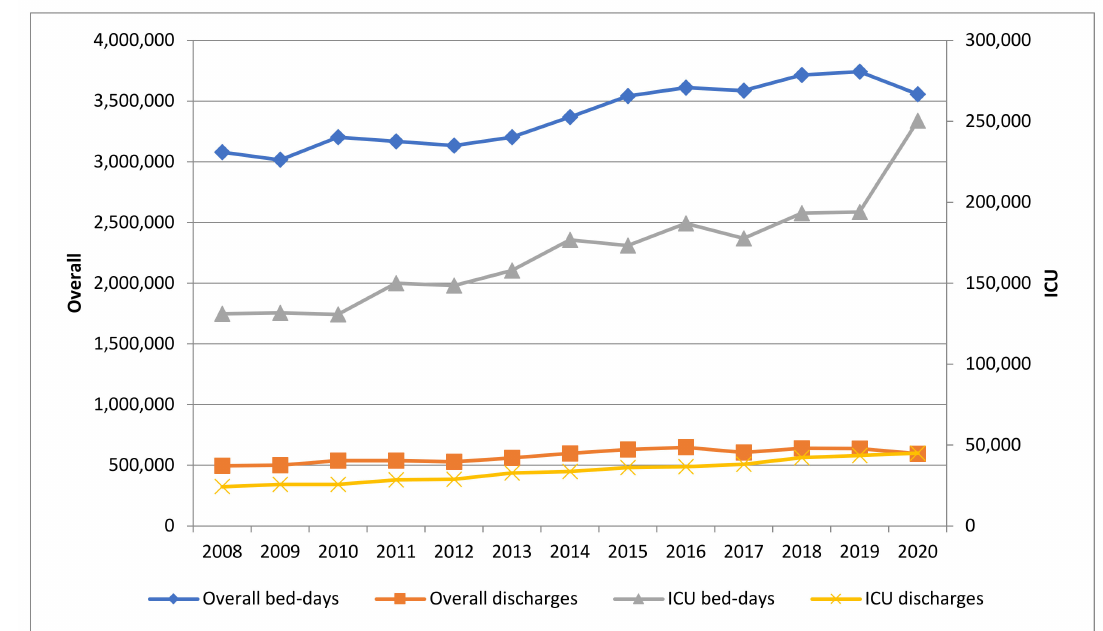
Figure 1. Evolution of overall and intensive care unit (ICU) bed-days and discharges